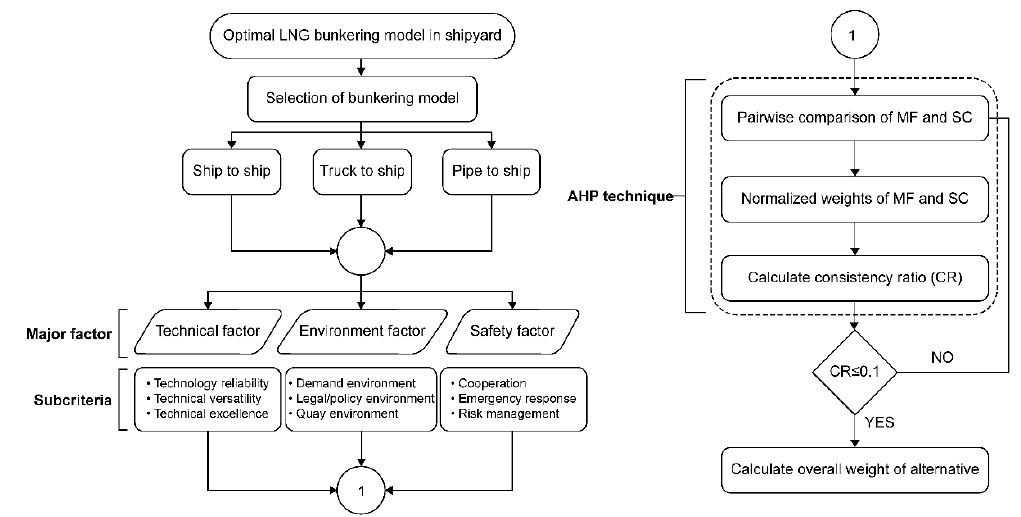
Figure 4. AHP framework for optimal LNG bunkering model in shipyard. Table 4. Classification and description on decision-making hierarchy of LNG bunkering method selection in a shipyard. Category